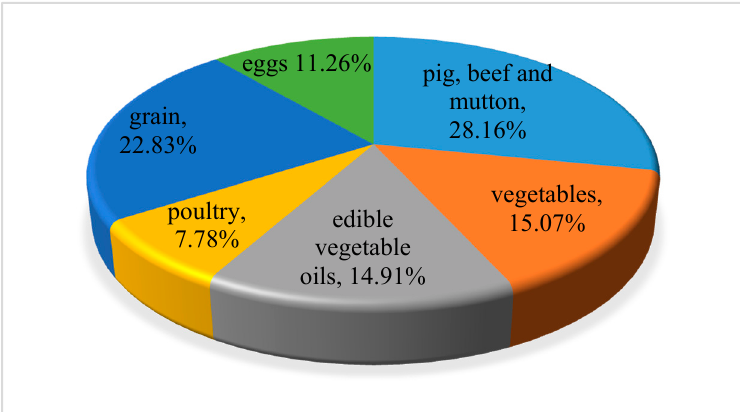
Figure 5. The proportion of water footprint consumed by each type of food of urban residents.